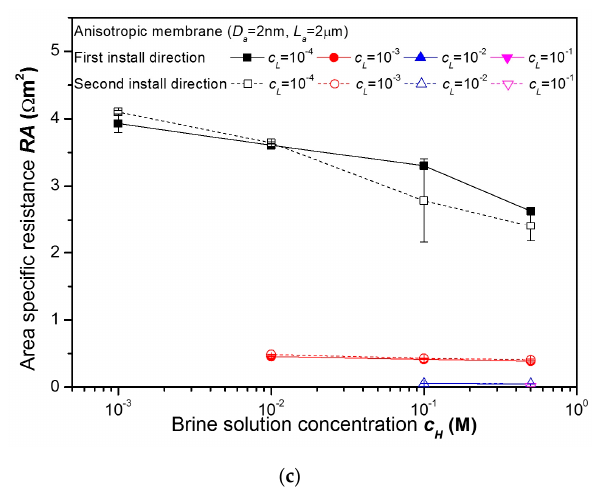
Figure 11. A comparison of: ( a ) power densities, ( b ) diffusion potentials, ( c ) area specific resistances of the anisotropic nanoporous anodic aluminum oxide membranes with two different install directions for various combinations of concentrations.